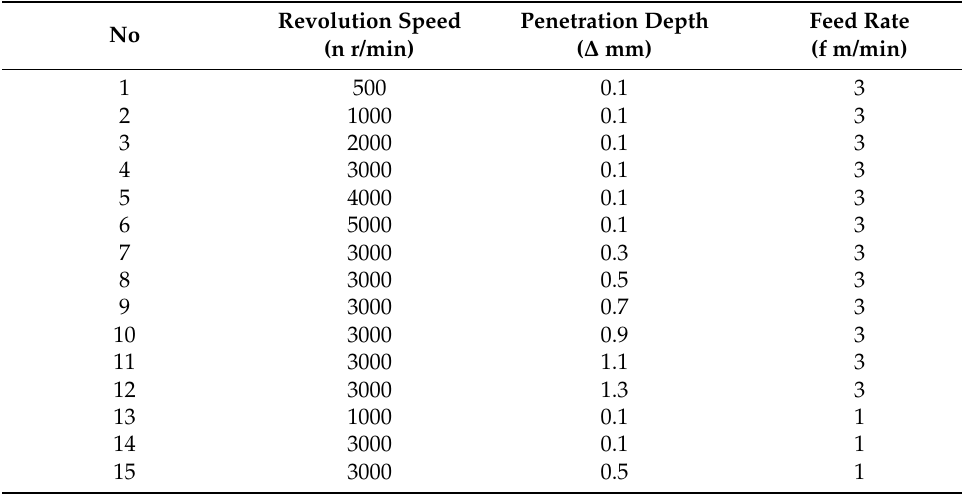
Figure 4. Abrasive brush grinding model. Table 1. The process parameters of brush grinding.